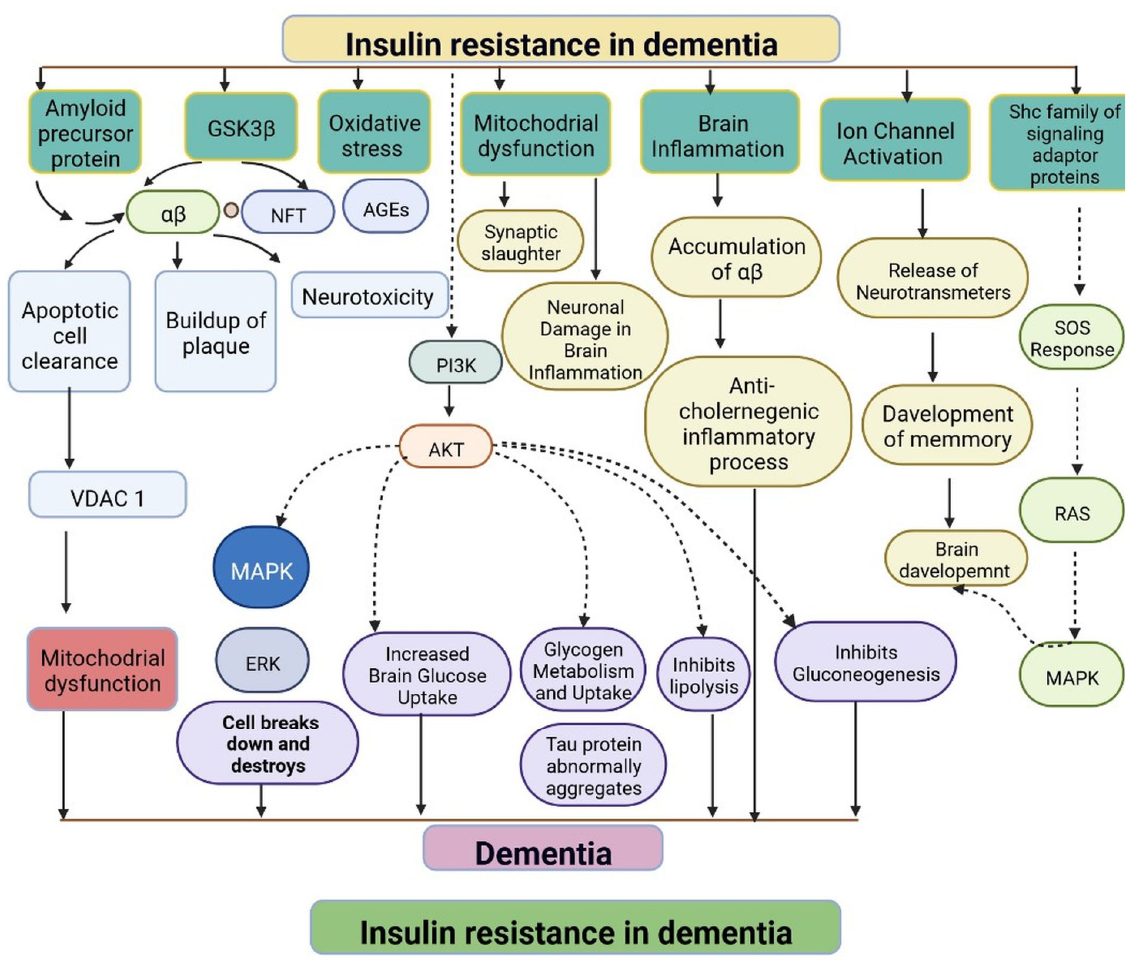
Figure 6. Representation of IR in dementia: resistance to insulin leads to mitochondrial dysfunction, damage to brain cells, altered brain glucose, aggregation of tau protein, inhibition of the lipolysis process, and an anticholinergic inflammatory process. The dotted lines represent inhibitory mecha- nisms.